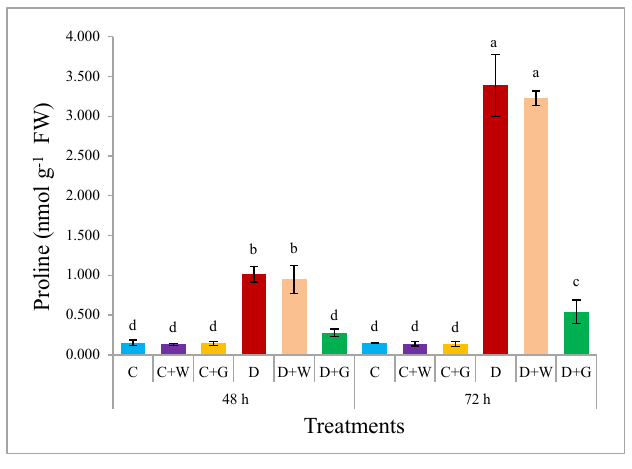
Fig. 3 Effect of drought stress and exogenous GA on free proline content in wheat seedlings. Codes are as for Fig.